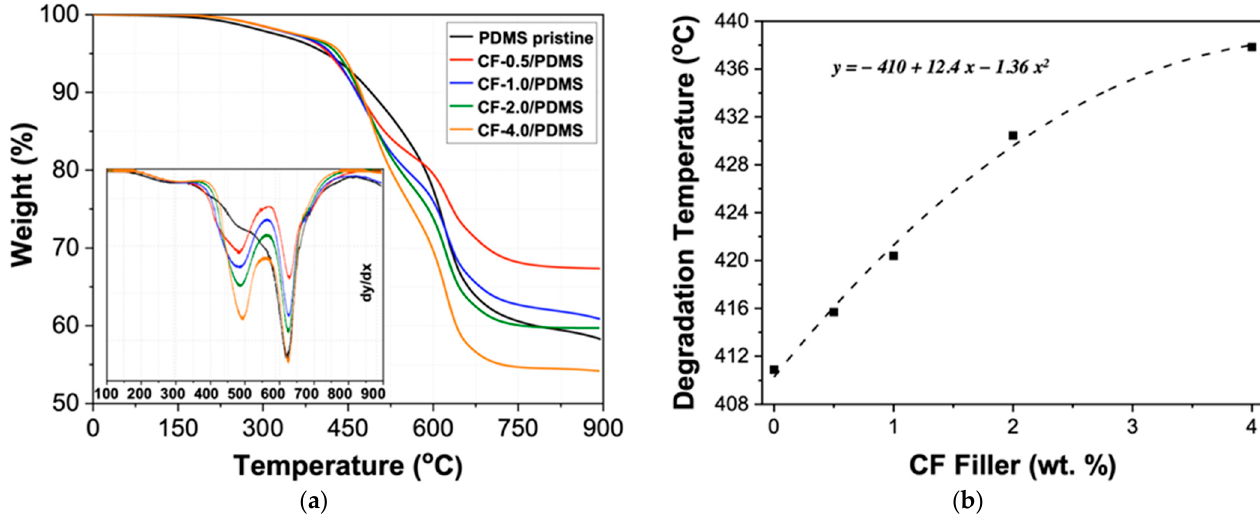
Figure 7. ( a ) Thermogravimetric analysis (TGA) for PDMS pristine and CF/PDMS samples. Inset: derivative curves. ( b ) Degradation temperature (Td; 5% weight loss). Table 2. Thermal degradation behaviors of PDMS pristine and CF/PDMS samples.